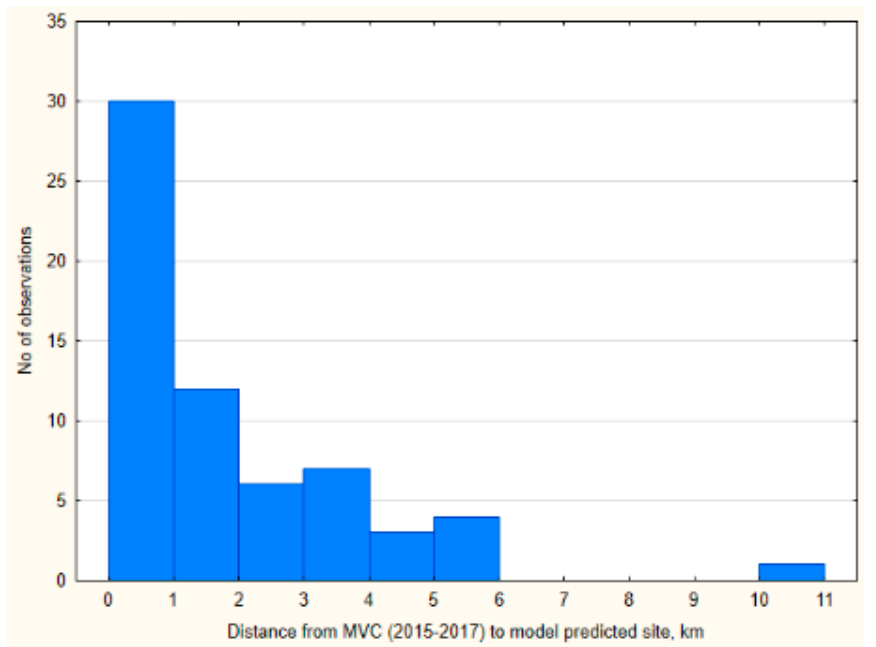
Figure 7. Prediction of moose movement model showing the distribution of distances between MVC locations in 2015–2017 ( n = 63) and locations predicted by the model in 2013. Distances are rounded to the nearest km; for higher accuracy see Table S1.